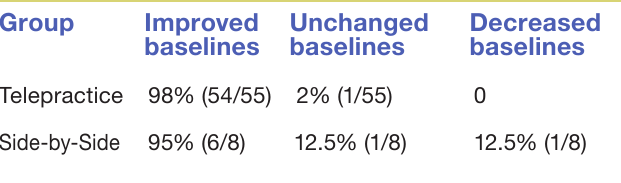
Table 6. Comparison of performance from baseline to post-intervention for both participant groups.